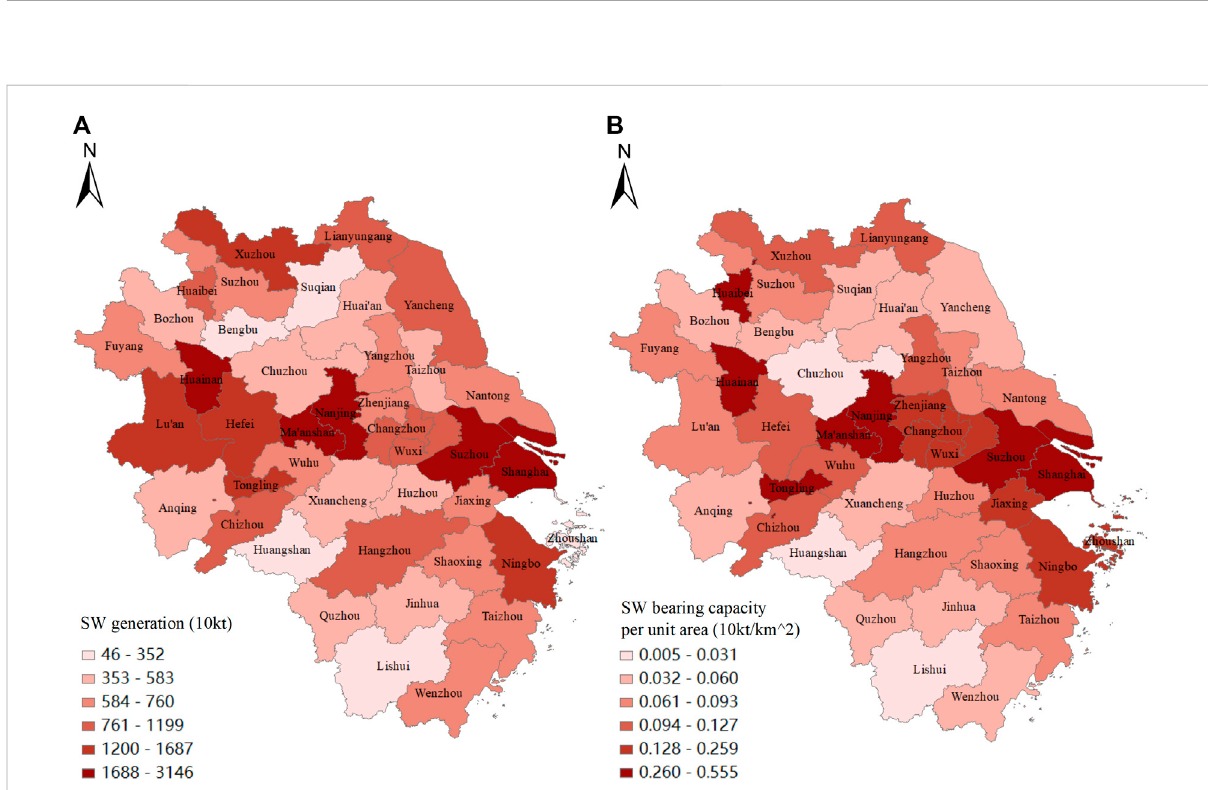
FIGURE 2 (A) Solid waste generation indifferentcitiesinthe YangtzeRiver Delta in2020. (B) Solid wastebearing strength per unitarea indifferentcitiesin the Yangtze River Delta in